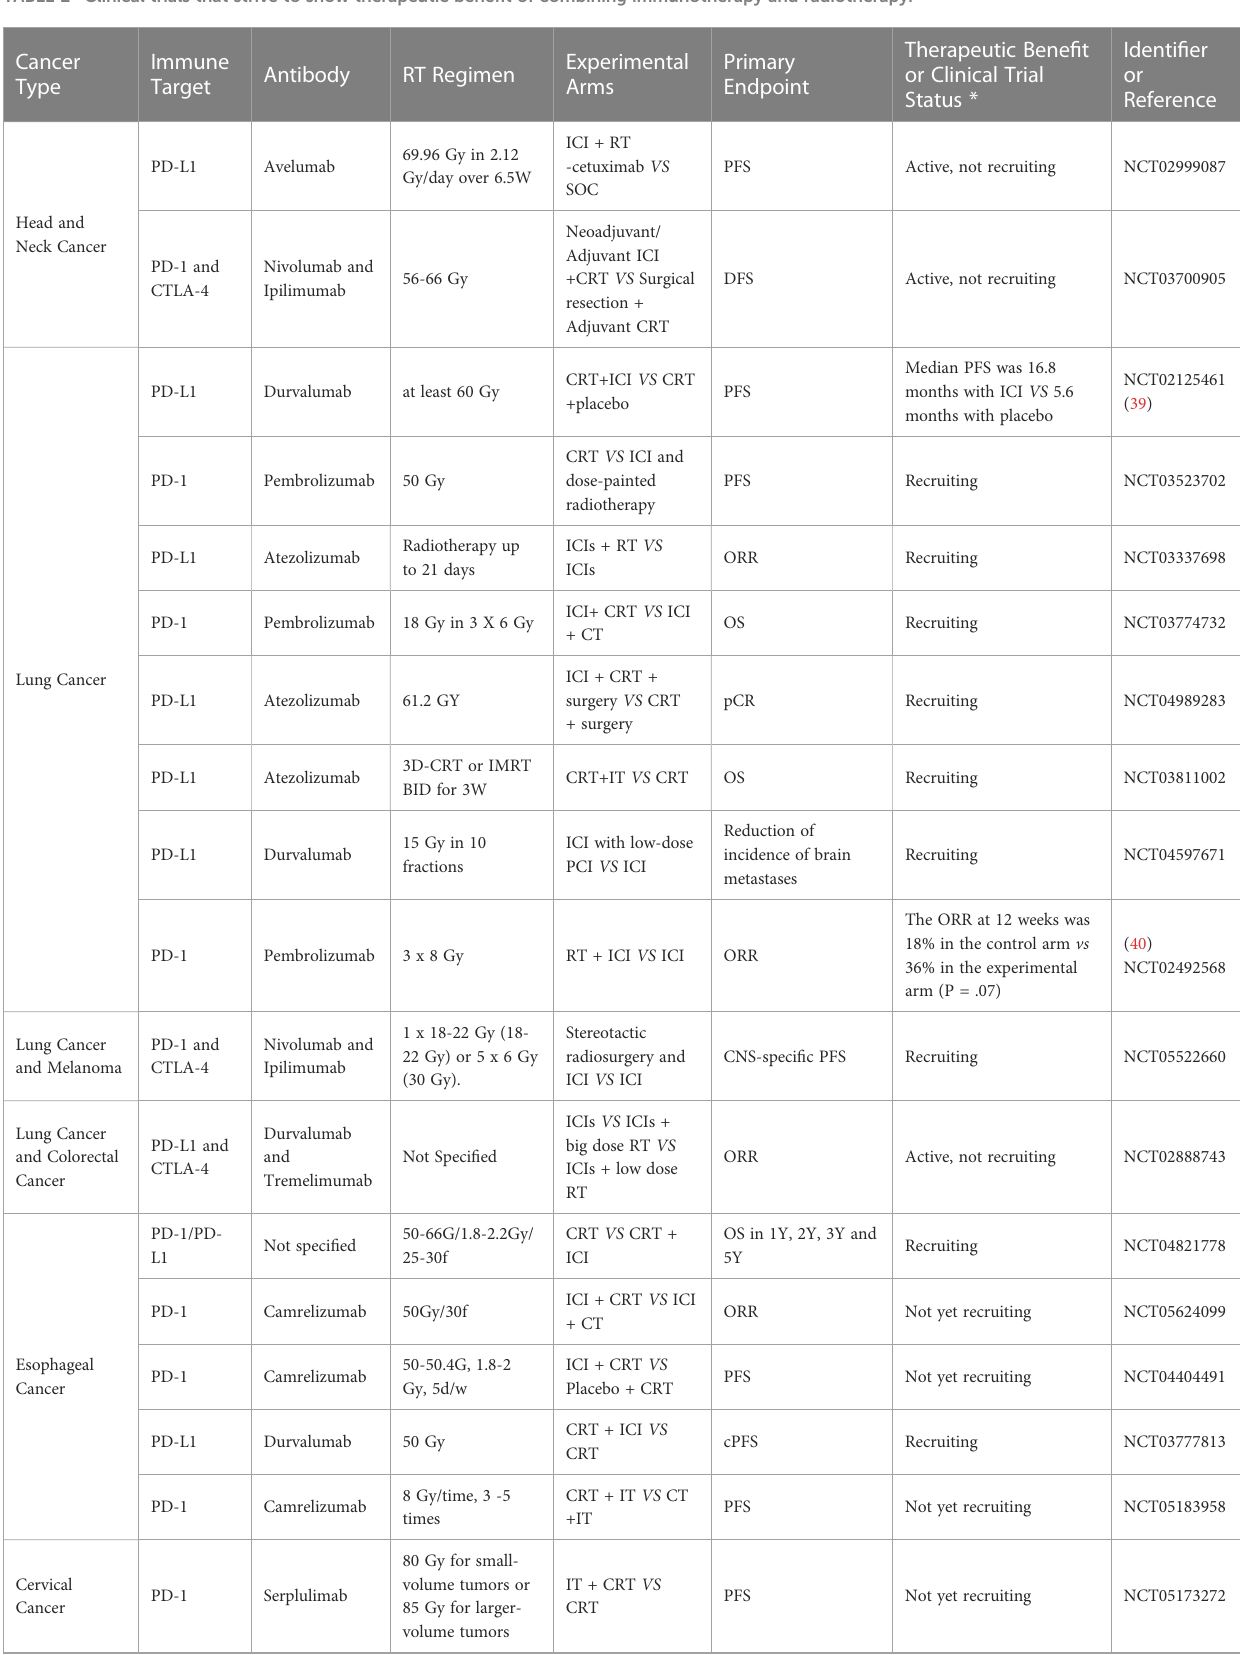
TABLE 2 Clinical trials that strive to show therapeutic bene fi t of combining immunotherapy and